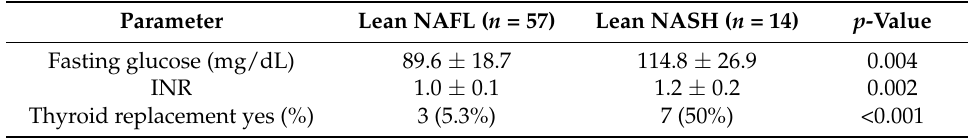
Table 5. Comparison of clinical and biochemical characteristics identified to be predictors for NASH in lean patients between lean NAFL and lean NASH patients in the multivariate